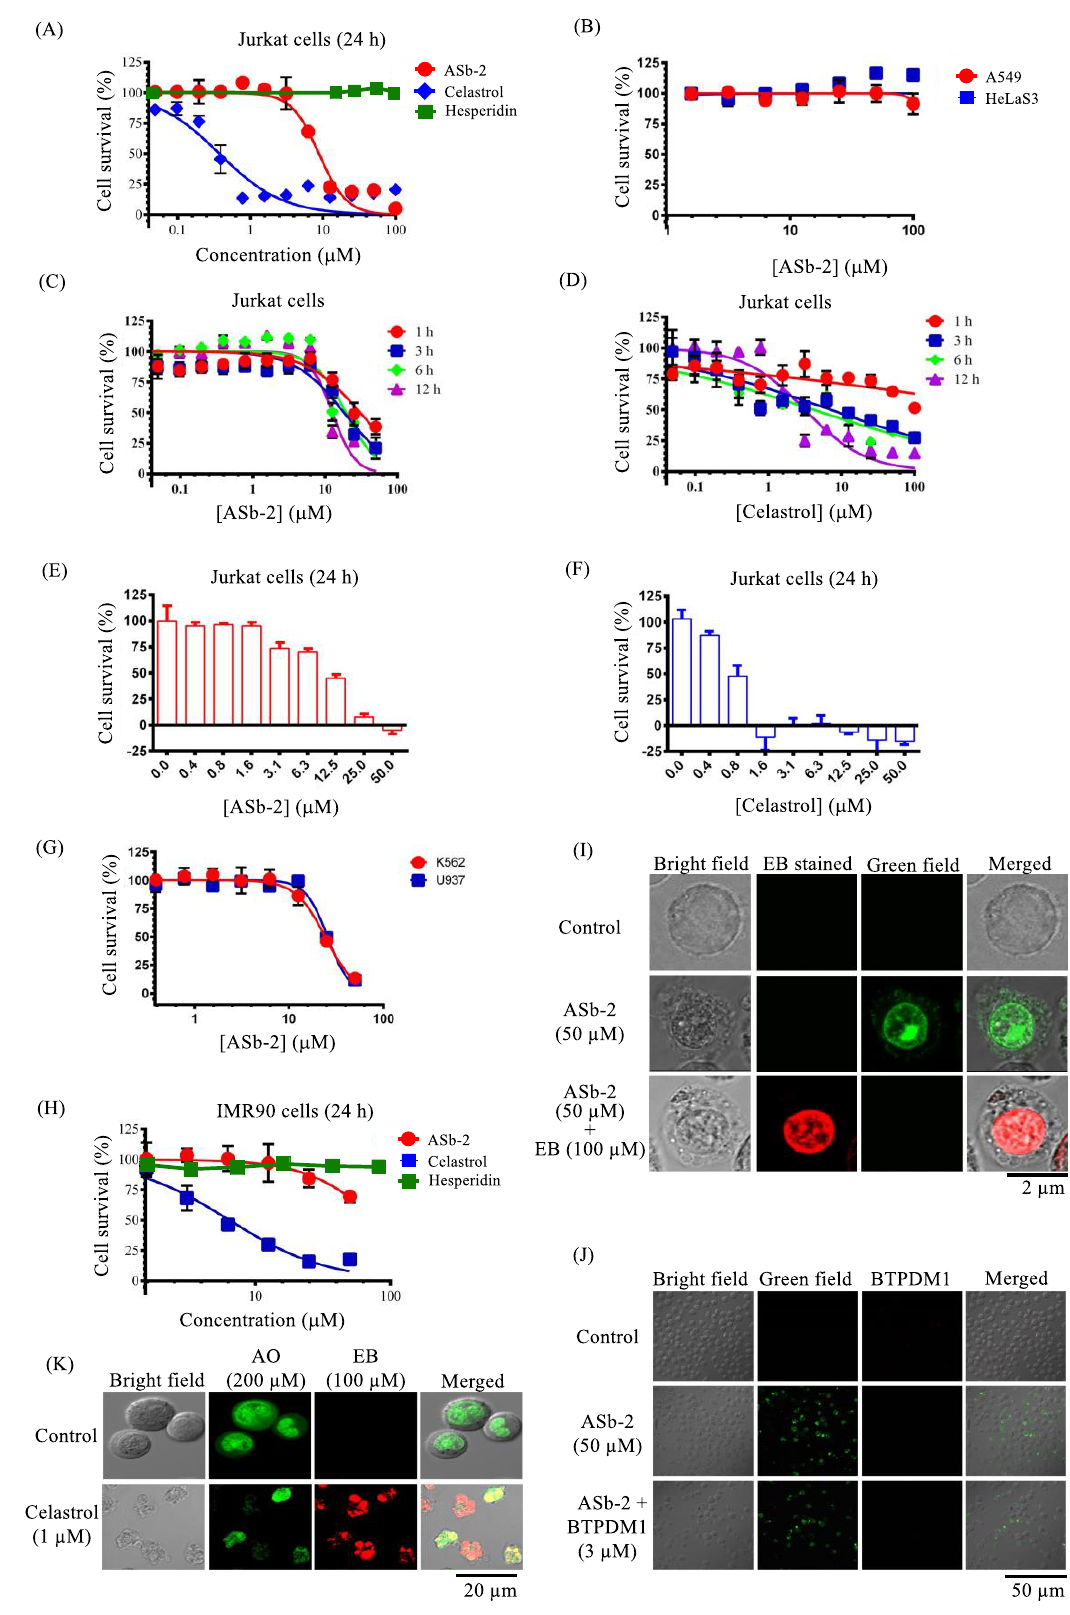
Figure 2. ( A ) The results of MTT assays of Jurkat cells treated with ASb-2 (red spheres), celastrol (blue diamonds), and hesperidin (green squares) for 24 h at 37 °C. ( B ) The results of MTT assays of A549 and HeLaS3 cells treated with ASb-2 (100 – 1.5 µM) for 24 h at 37 °C. ( C , D ) The results of MTT assays of Jurkat cells treated with ASb-2 and celastrol after the incubation for 1, 3, 6, and 12 h at 37 °C. ( E , F ) The cell counting results of Trypan blue assays of Jurkat cells treated with